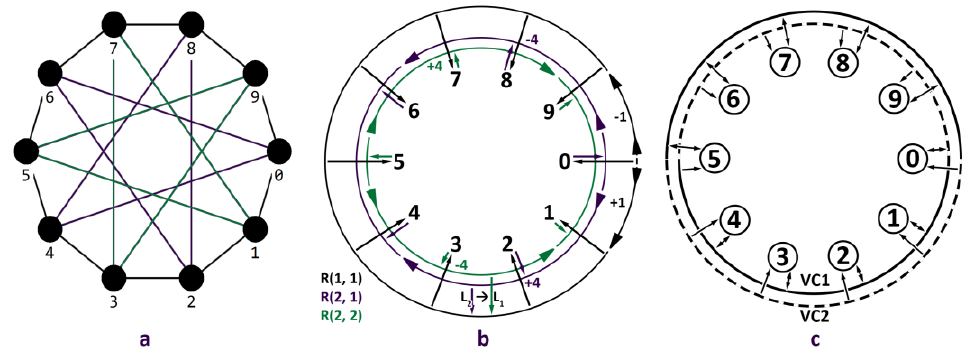
Figure 3. Structure of levels of the circulant 𝐶(10; 1, 4) : ( а) graph scheme; (b) levels of the graph; (c) virtual channels scheme. ( c ) virtual channels